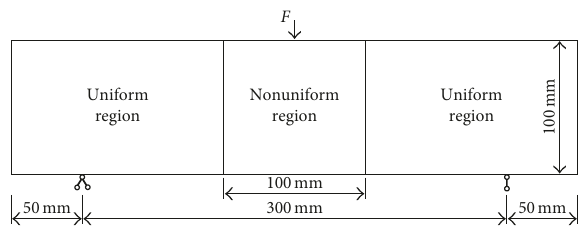
Figure 12: Three-point bending concrete beam calculation diagram.